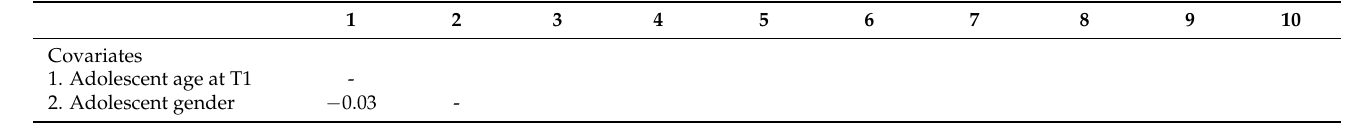
Table 1. The means, standard deviations, and correlation among the